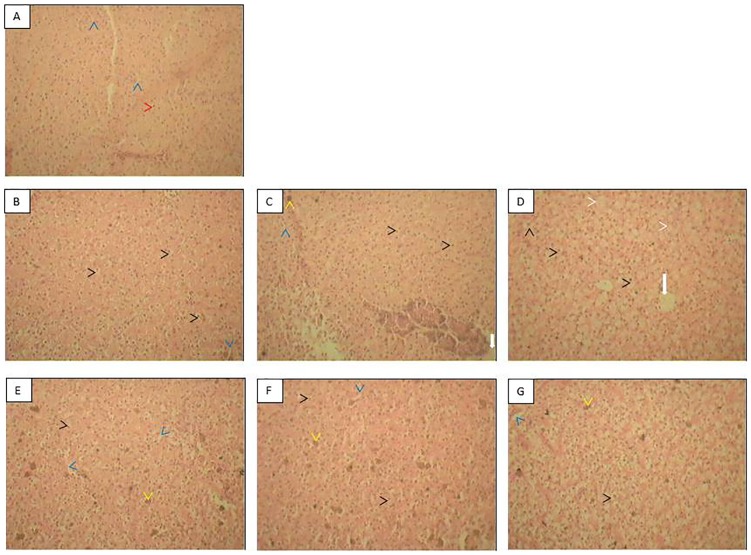
Secondary stress response to low dose endosulfan exposure in fish unfed or fed with lipotropes for 37 days: Histoarchitectural response.Histoarchitecture of the liver revealed a protective role for lipotropes in fish exposed to a nonlethal dose of endosulfan and intraperitoneally injected with the infectious bacteria, A. hydrophila. Pre-challenge samples were collected after 37 days of experiment. Post-challenge samples were collected at the end of 7 days in surviving fish or just before sacrificing severely morbid fish. Section from control fish (A), A. hydrophila injected fish (B), fish exposed to nonlethal dose of endosulfan (C) and also injected with A. hydrophila but either fed with no supplements (D), or fed with choline (E), betaine (F) or lecithin (G). Blue arrowhead: sinusoids, Red arrowhead: hepatocyte with nucleus, Black arrowhead: vacuole in hepatocyte, White arrow: central vein, White arrowhead: ghost cell without nucleus (due to karyolysis), Yellow arrowhead: focal inflammatory infiltrate. Histological changes are described in detail in the text.